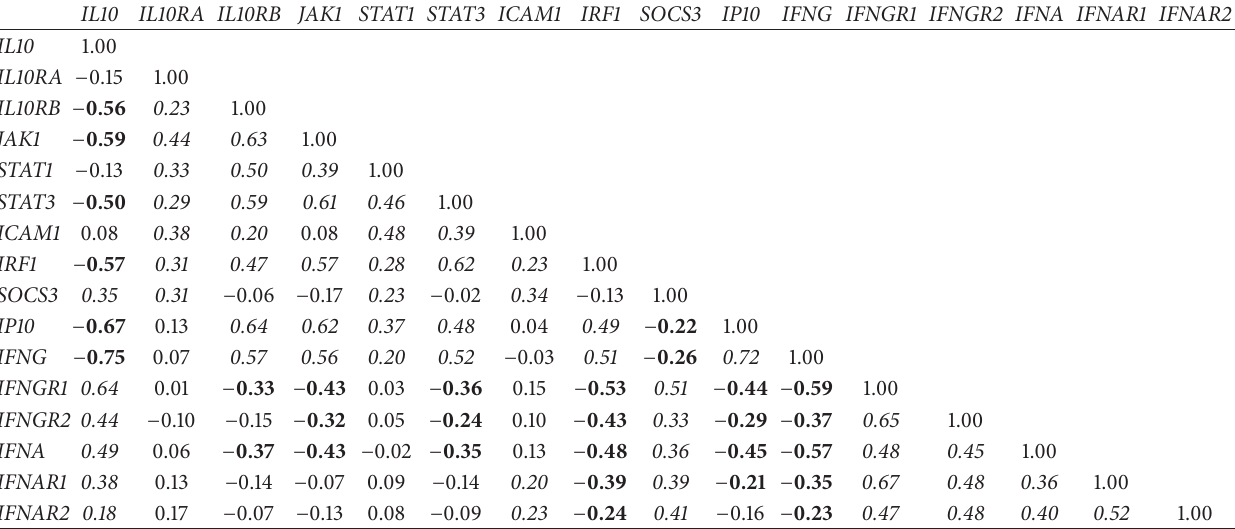
Table 4: Adjusted correlation of expressions between the investigated